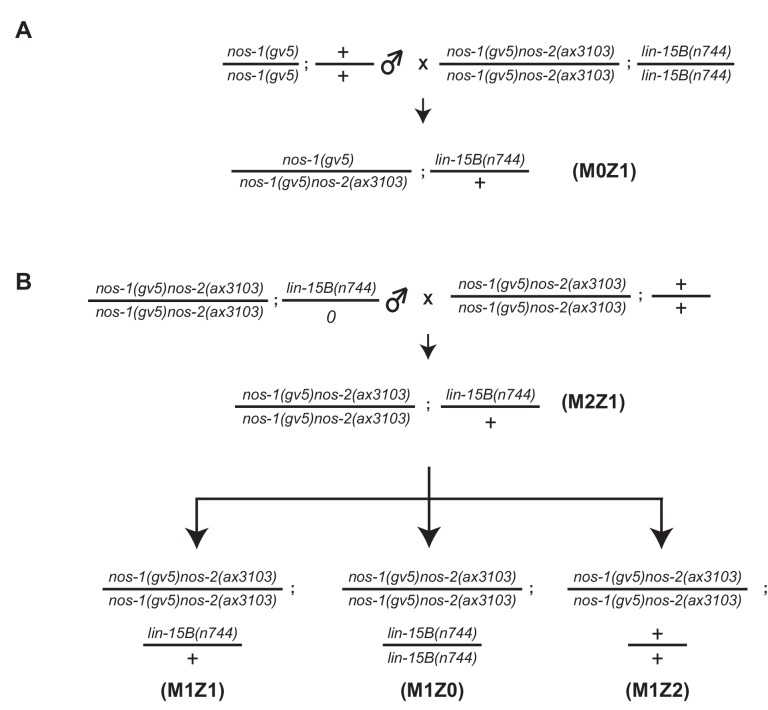
Assay for maternal and zygotic contribution of lin-15B in nos-1nos-2 sterility.(A–B) Mating schemes to characterize the maternal and zygotic contribution of lin-15B in nos-1(gv5)nos-2(ax3103). lin-15B genotypes were determined by Sanger sequencing (See key resources table for PCR/sequencing oligos).